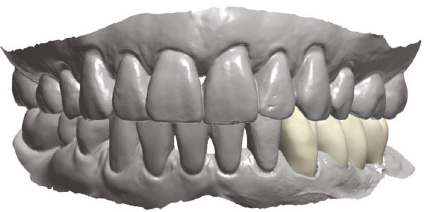
Figure 16: The design of the fi nal crowns in the CAD